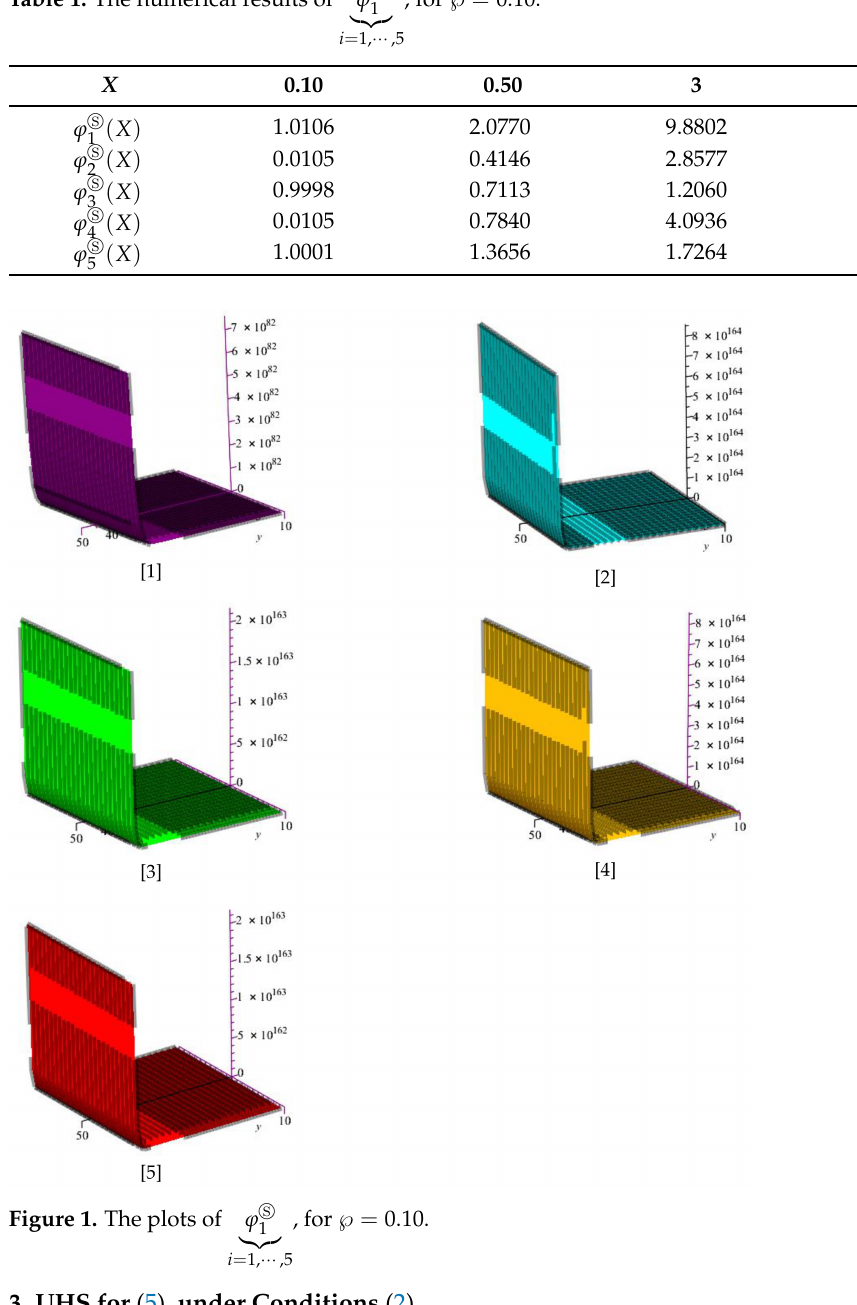
Table 1. The numerical results of ϕ